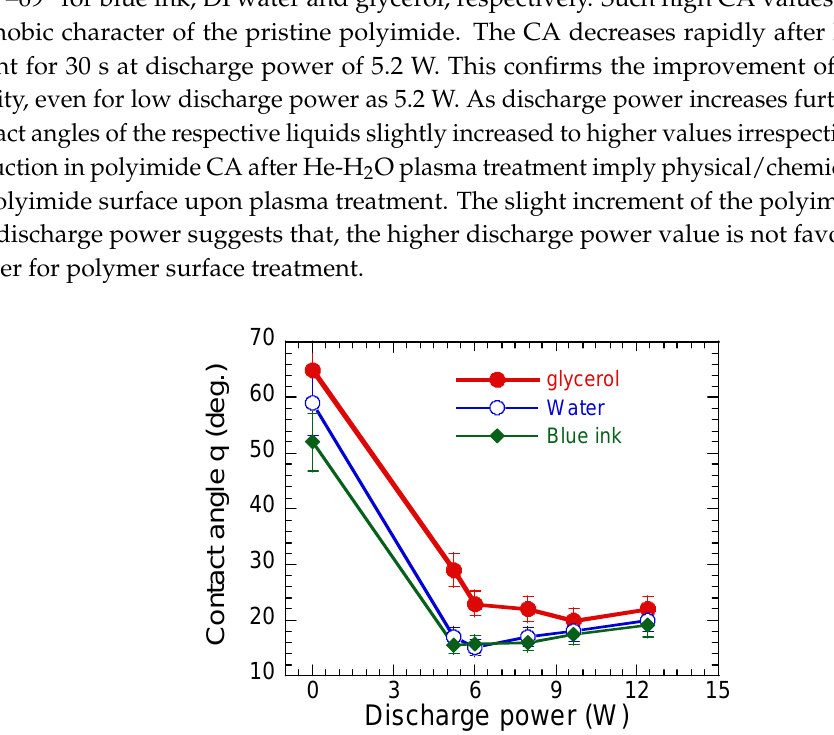
Figure 5. Contact angle θ measurements as a function of discharge power at conditions of total flow rate 10 L/min and treatment time of 30 s for three various